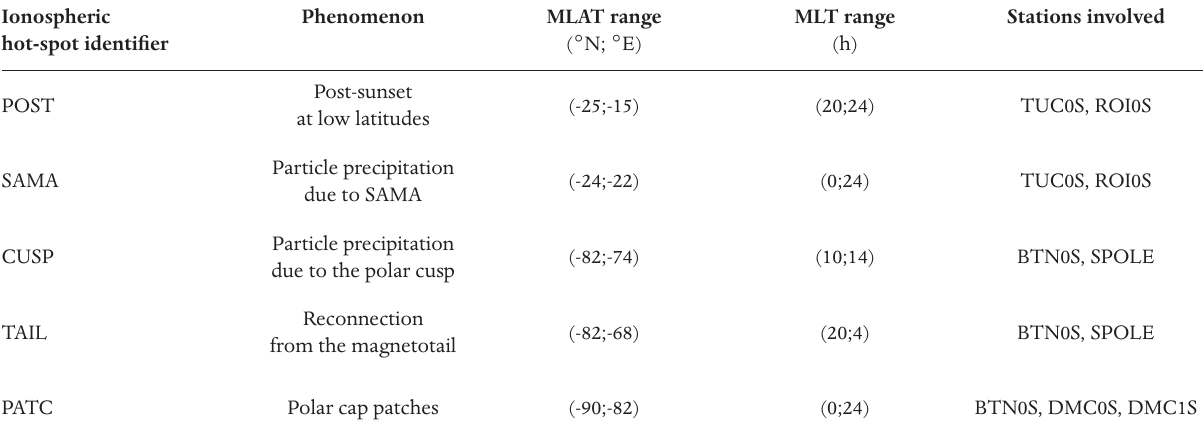
Table 4. Ionospheric scintillation hot spots defined in terms of the MLT and Mlat ranges.